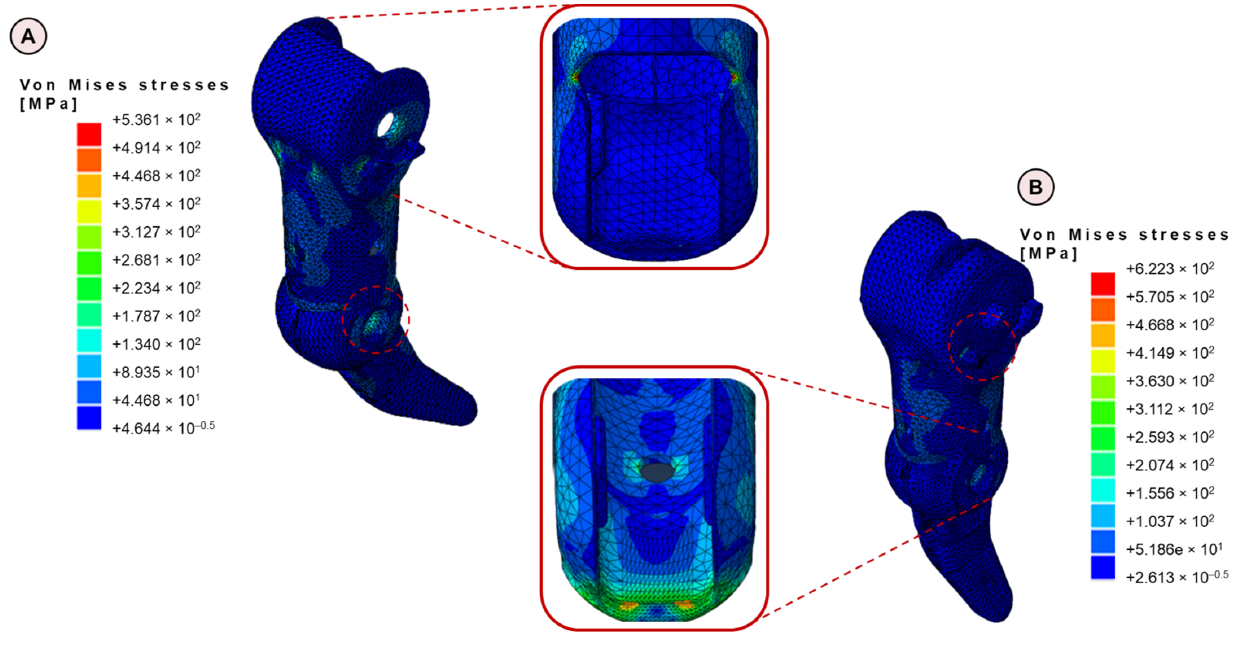
Figure 6. ( A ) Computational results in terms of Von Mises stresses for the finger; ( B ) computational results in terms of Von Mises stresses for the thumb. For both numerical models, a zoom on the regions subjected to higher stresses is reported.